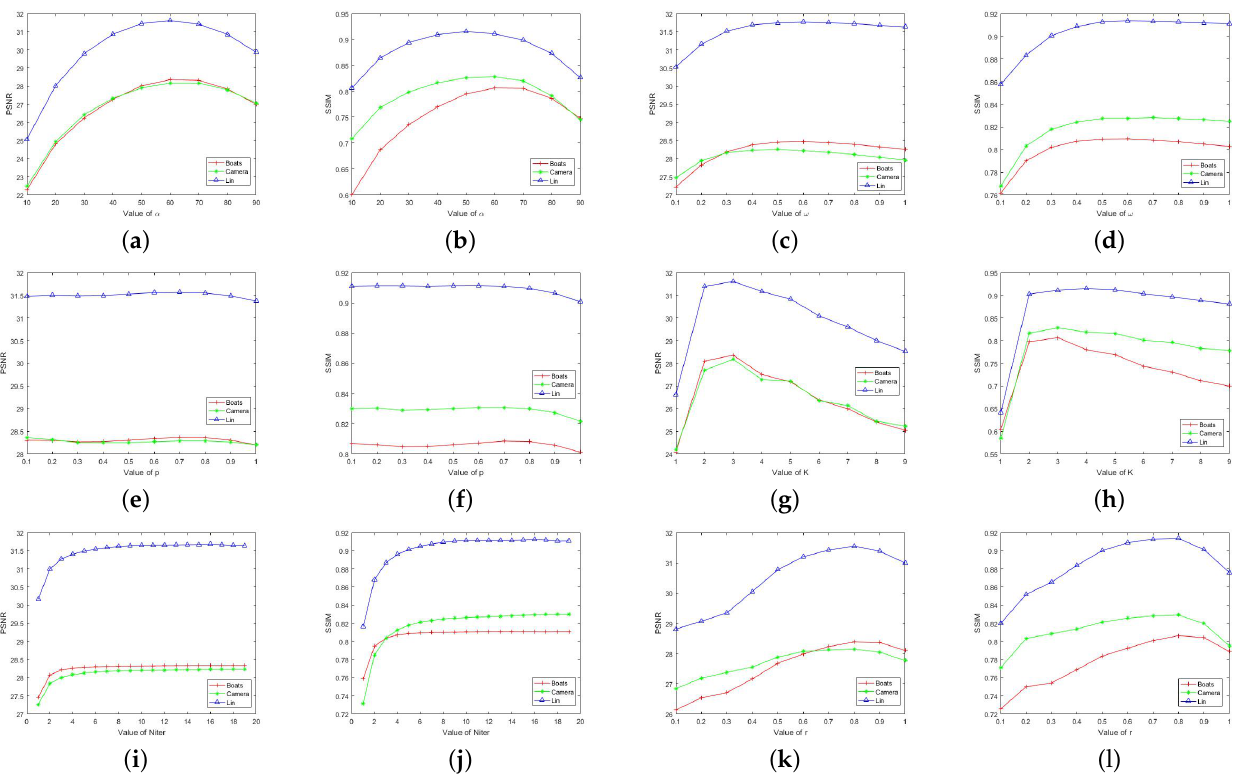
Figure 2. ( a – l ) The PSNR and SSIM values with respect to the parameters α , ω , p , K , Niter , and r